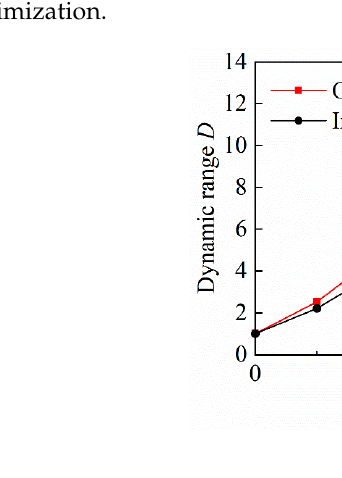
Figure 13. Comparison of simulation with the initial and optimal MR damper. ( a ) Damping force; ( b ) dynamic range.